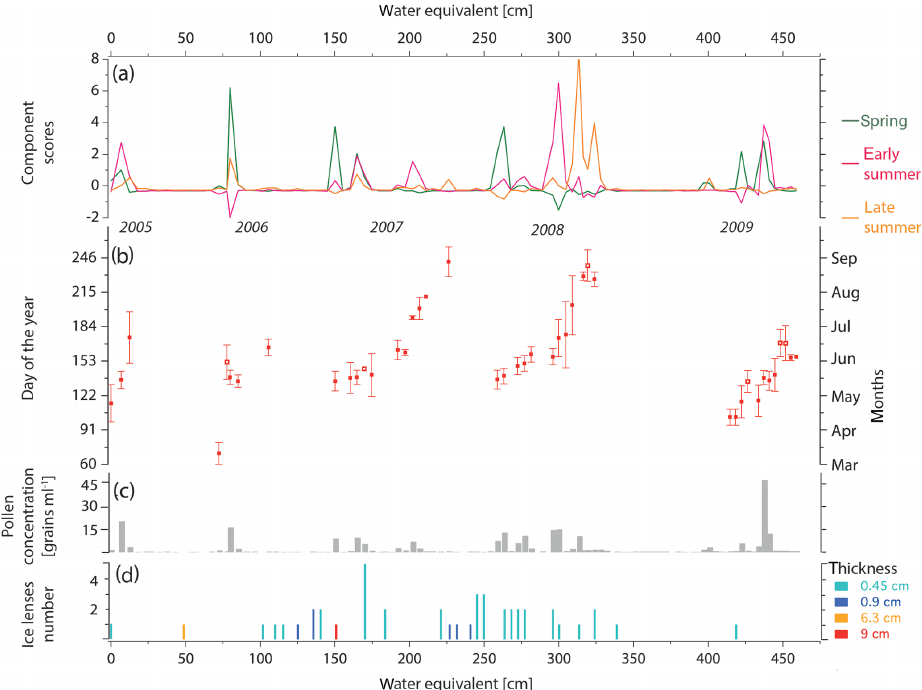
Figure 2. (a) Mt. Ortles firn core 2009 timescale (Festi et al., 2015) based on principal component analyses. As every principal component (PC) condenses the seasonal information of the pollen spectrum, scores values should to be interpreted as follows: a sample (w.e. depth down) presenting high component scores values for a specific PC is characterized by a pollen content reflecting predominantly the season corresponding to that particular PC. (b) Mean date (day of the year ± 1 sigma) obtained by using the new method developed in this paper; empty squares represent inversions. (c) Pollen concentration in the Mt. Ortles 2009 firn core. (d) Number and mean thickness (color scale) of ice lenses per